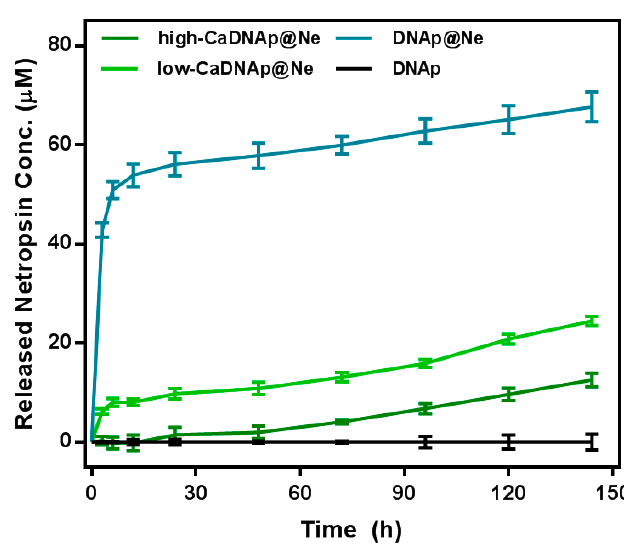
Figure 5. Netropsin release efficiency of DNAp@Ne and CaDNAp@Ne. A cumulative graph of the three samples produced under the same conditions is shown ( n = 3). For each time point, the sample supernatant was measured using a UV–vis spectrometer (DNAp: black, DNAp@Ne: blue, low-CaDNAp@Ne: light green, high-CaDNAp@Ne: green).